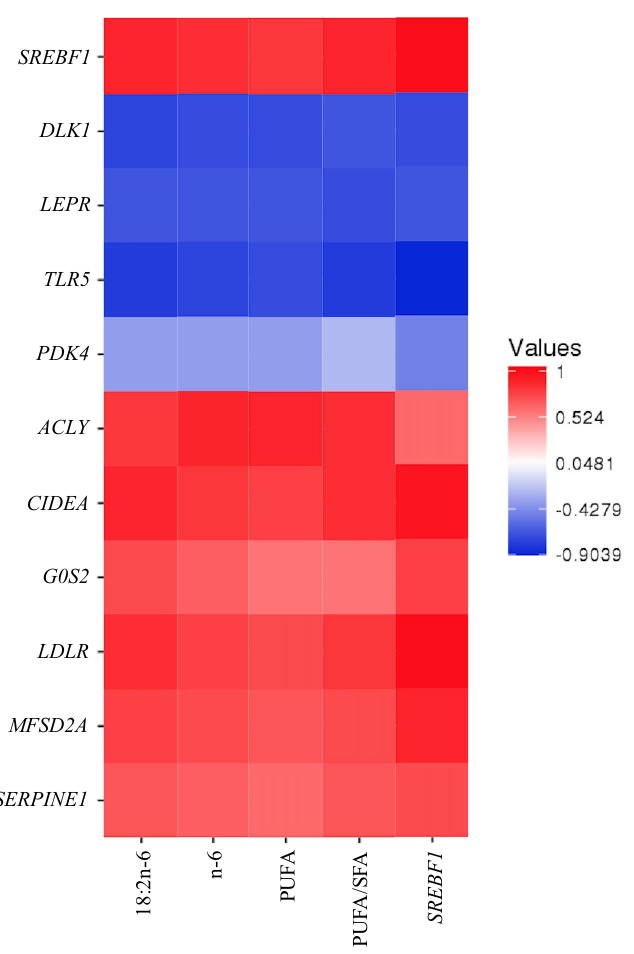
Figure 4. Spearman correlation analysis among the DE gene reads, and between the DE gene reads and FA composition. The correlation coefficient is colored by different intensities of red (positive correlation) and blue (negative correlation). DLK1 = delta like non-canonical Notch ligand 1; LEPR = leptin receptor; TLR5 = toll like receptor 5; PDK4 = pyruvate dehydrogenase kinase 4; ACLY = ATP citrate lyase; CIDEA = cell death-inducing DFFA-like effector a; G0S2 = G0/G1 switch 2; LDLR = low density lipoprotein receptor; MFSD2A = major facilitator superfamily domain containing 2A; SERPINE1 = serpin family E member 1; SREBF1 = sterol regulatory element binding transcription factor 1; n-6 (sum of omega 6 fatty acids) = 18:2n-6 + 20:3n-6 + 20:4n-6; PUFA (sum of polyunsaturated fatty acid) = 18:2n-6 + 20:3n-6 + 20:4n-6 + 18:3n-3; PUFA/SFA = ratio of PUFA to